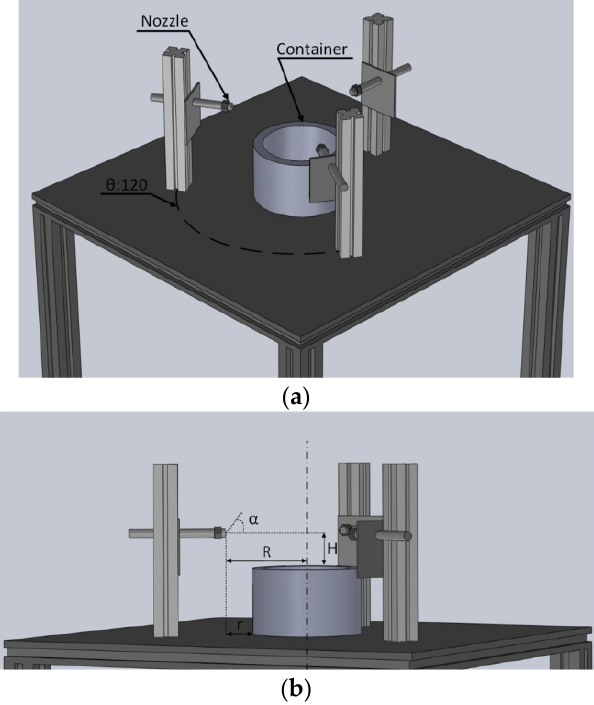
Figure 13. Experimental setup—water mist system with simultaneous use of three nozzles: ( а )—enlarged view showing details of position of nozzles; ( b )—isometric view [74].